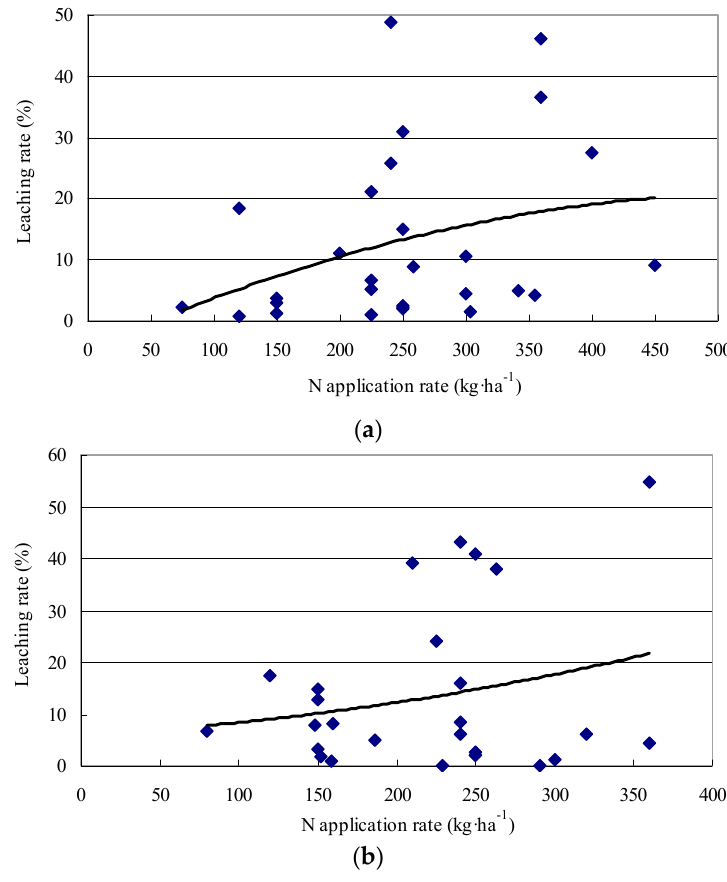
Figure 1. Relation between the nitrogen application rate and the leaching rate of wheat ( a ) and maize ( b ).